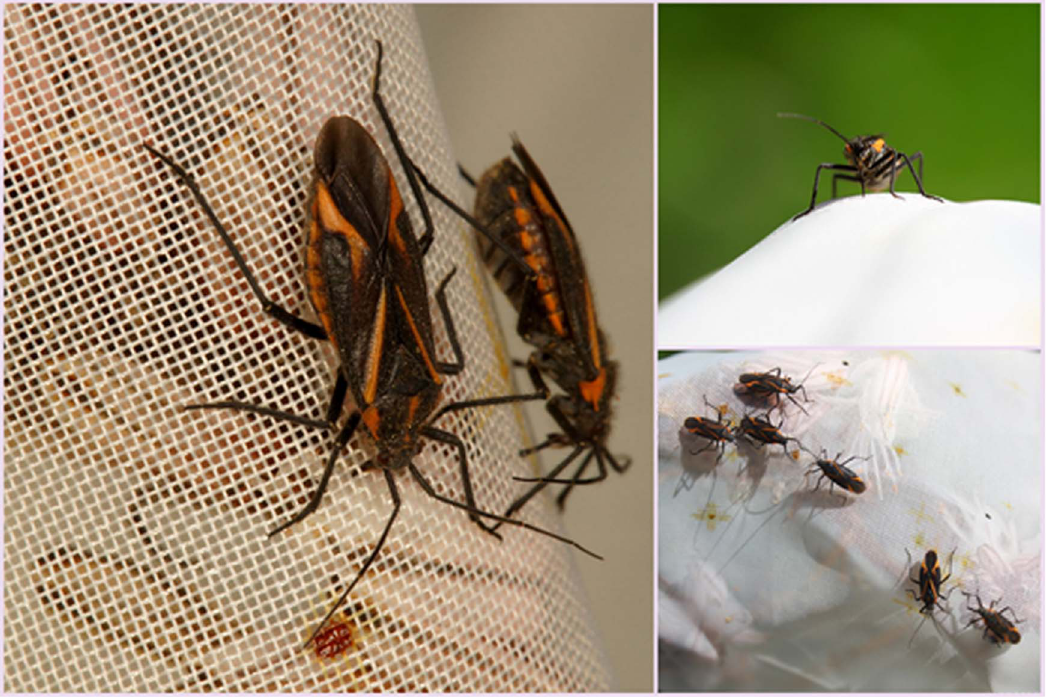
Figure 6. Adult mirid bugs ( Capsodesinfuscatus ) on bagged flowers inserting their piercing-sucking mouthparts through the bag and into the flower. The orange marks on the covering bags are the bugs’ waste.